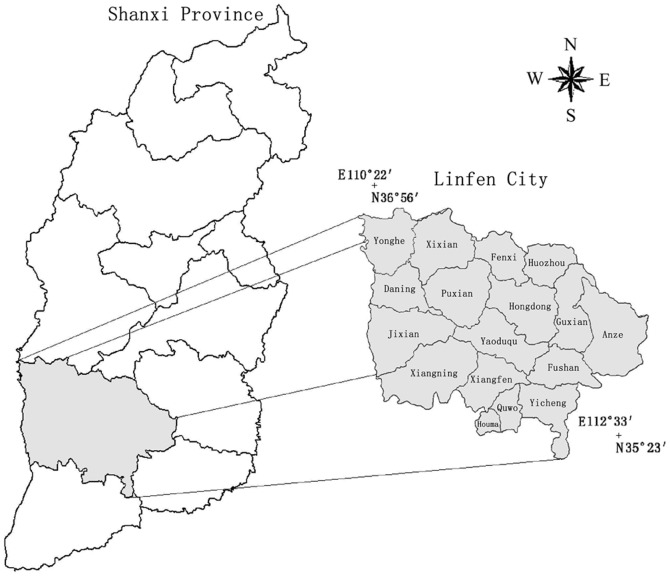
The locations of the study area.